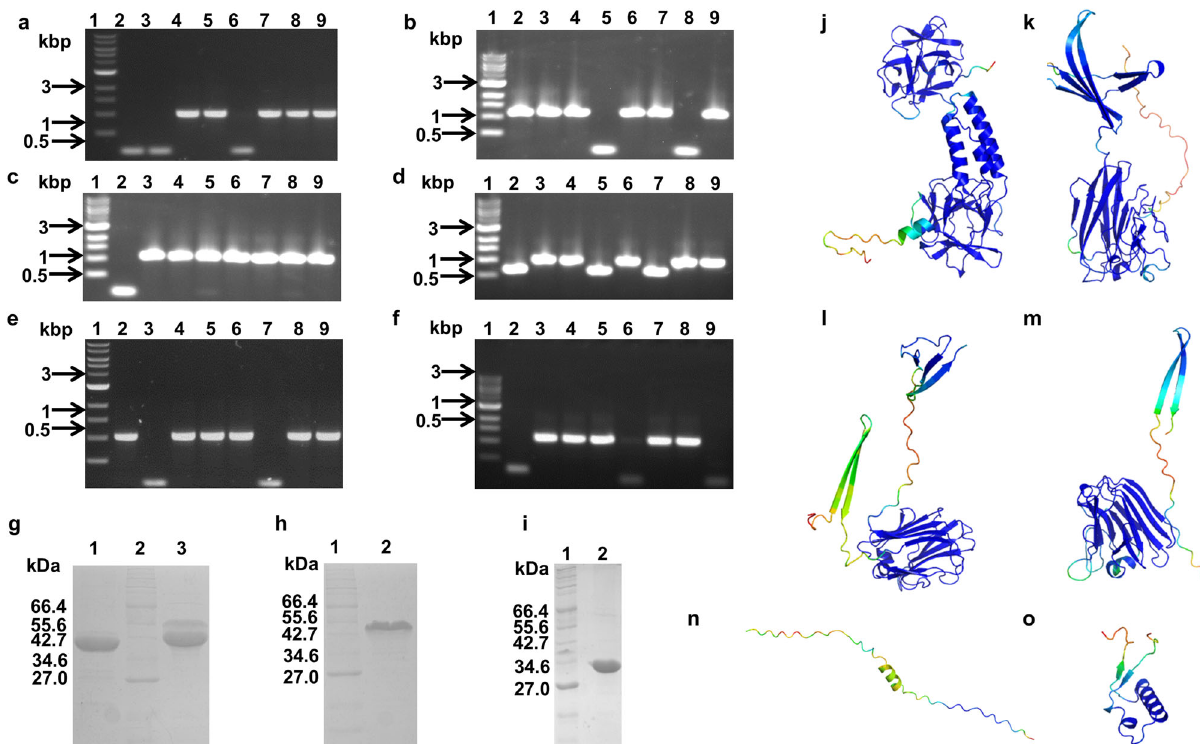
Fig. 2 Identi fi cation of mucin binding protein domains. a – f Agarose gel electrophoresis of PCR amplicons indicating the presence or absence of any recombinant insert following biopanning of the metagenomic phage display library against porcine stomach type II mucin. Results of a single screening experiment. a Lane 1: 1 kbp DNA marker. Lanes 2 – 9: Phages eluted with L-fucose, b Lane 1: 1 kbp DNA marker. Lanes 2 – 9: Phages eluted with D-galactose, c Lane 1: 1 kbp DNA marker. Lanes 2 – 9: Phages eluted with GalNAc, d Lane 1: 1 kbp DNA marker. Lanes 2 – 9: Phages eluted with GlcNAc, e Lane 1: 1 kbp DNA marker. Lanes 2 – 9: Phages eluted with D-mannose, f Lane 1: 1 kbp DNA marker. Lanes 2 – 9: Phages eluted with sialic acid (Neu5Ac), g Coomassie blue stained SDS-PAGE showing puri fi ed MG1 and MN3 proteins in the imidazole eluates following Ni-NTA metal ion af fi nity chromatography; Lane 1: Puri fi ed MG1 protein; Lane 2: Protein marker from NEB (2-212 kDa); Lane 3: Puri fi ed MN3 protein, h Coomassie blue stained SDS-PAGE showing puri fi ed MU1 protein in the imidazole eluates following Ni-NTA metal ion af fi nity chromatography; Lane 1: Protein marker from NEB (2 – 212 kDa); Lane 2: Puri fi ed MU1 protein, i Coomassie blue stained SDS-PAGE showing puri fi ed MU3 protein in the imidazole eluates following Ni-NTA metal ion af fi nity chromatography; Lane 1: Protein marker from NEB (2 – 212 kDa); Lane 2: Puri fi ed MU3 protein. j – n AlphaFold2 predicted structures of MG1 ( j ), MN3 ( k ), MU1 ( l ), MU3 ( m ), MF12 ( n ), and MF12F2 ( o